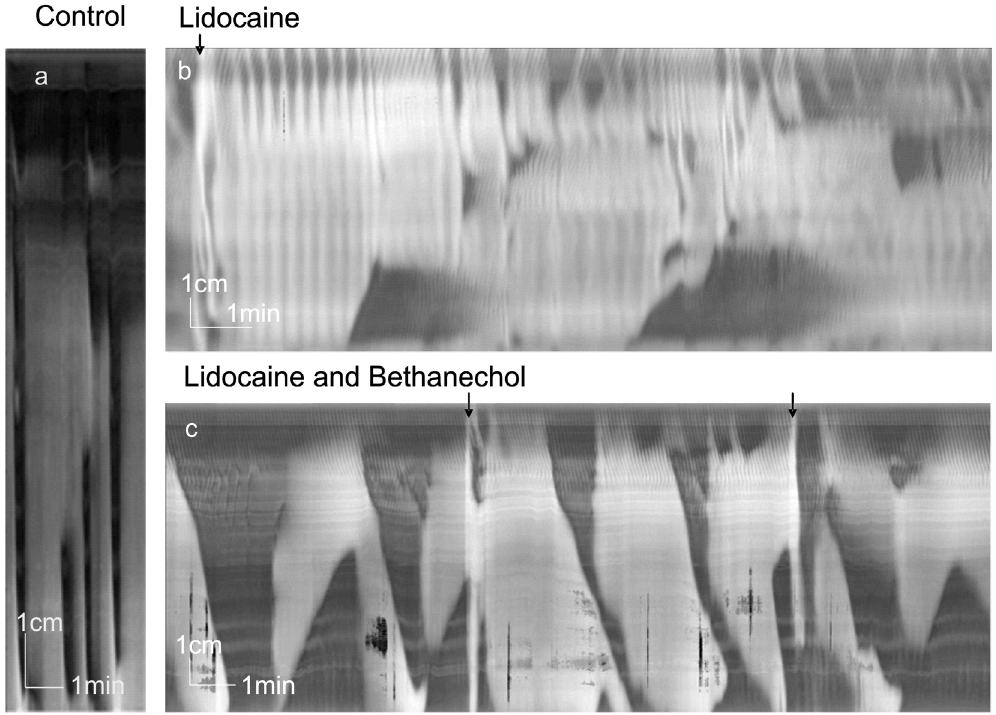
Figure 4. Lidocaine and bethanechol. Spatiotemporal maps created from video recordings of motor patterns of the whole rat colon. All arrows indicate infusion of PBS into proximal colon. a. Control LDCs with distal RPMCs. b. Lidocaine abolished LDCs but rhythmic contractile activity remained up to 6/min. Two retrograde contractions were seen. Lidocaine was added 3 min before start of panel b. c. Addition of bethanechol (2 6 10 2 6 M) introduced LDC-like activity as well as retrograde contractions in the distal colon. Fluid infusion effects were variable, sometimes without effect (first arrow), sometimes inducing a propulsive contraction. Bethanechol was added 14 min before start of panel c.